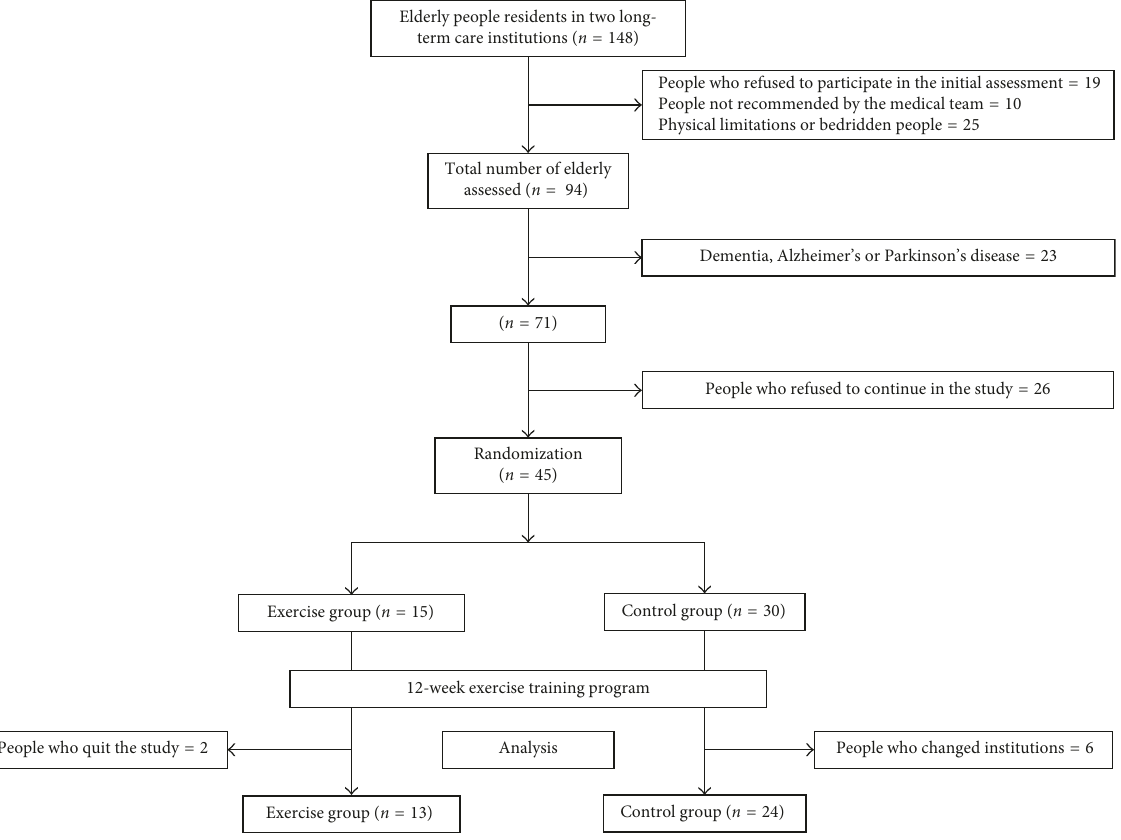
Figure 1: A schematic drawing of the